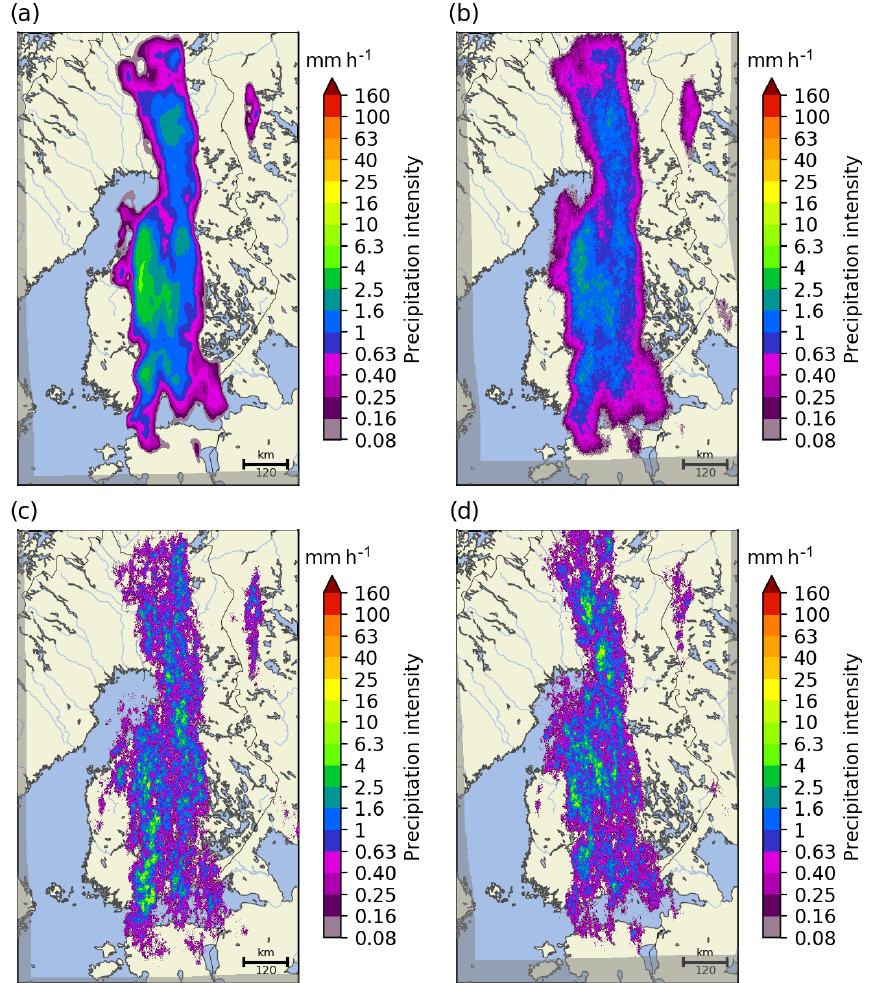
Figure 25. The deterministic S-PROG nowcast (a) , ensemble mean (b) and two ensemble members (c, d) of a 1h STEPS nowcast starting at 16:00UTC on 28 September